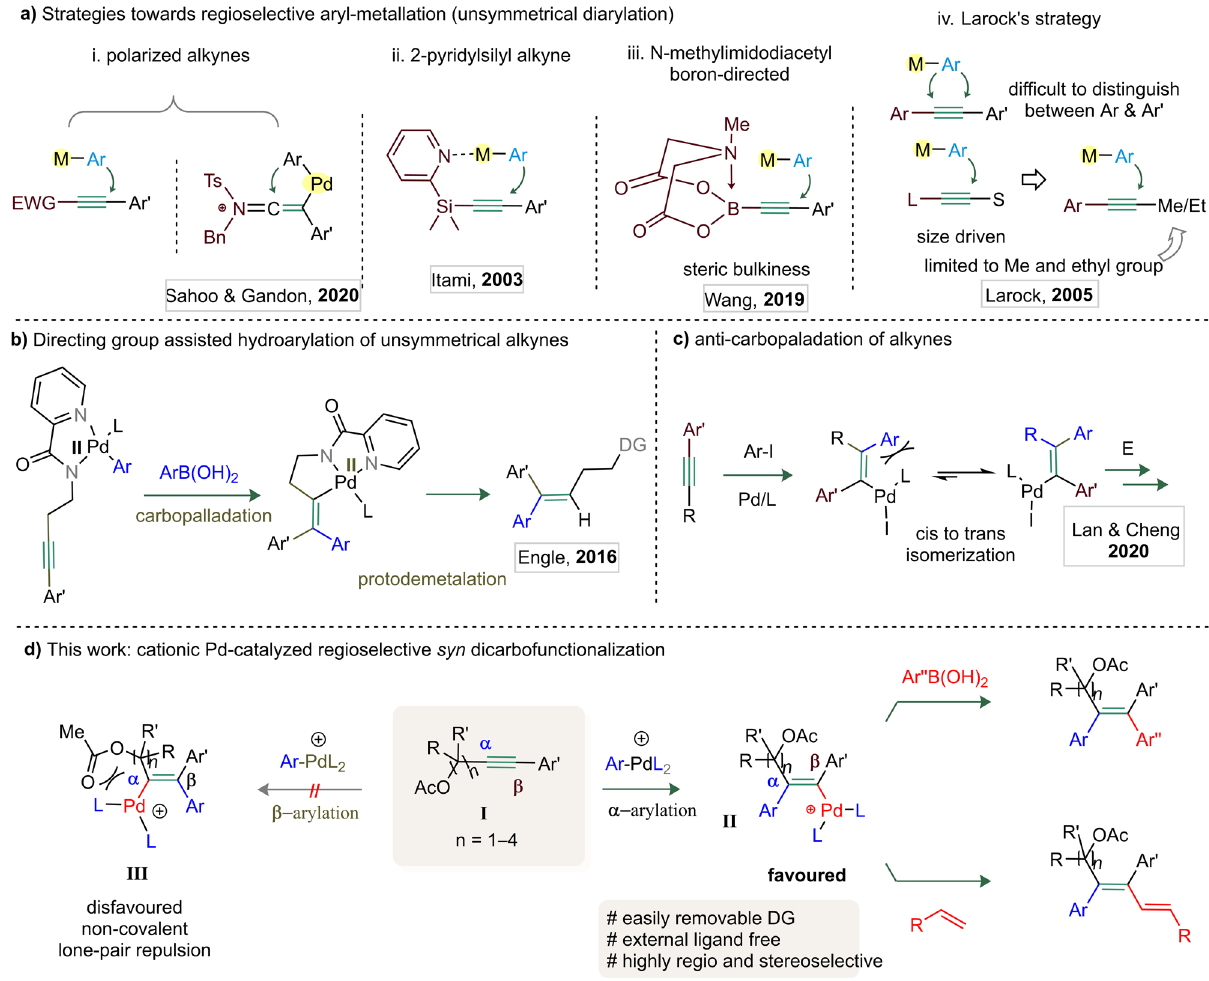
Fig. 1 Comparison between hydro- and difunctionalization of alkynes and the conceptual blueprint of a general cationic Pd-catalyzed dicarbofunctionalization of Yne-acetates. a (i) Difunctionalization of electronically polarized alkynes: the incoming aryl group forms bond at the electron- de fi cient carbon center. (ii) Difunctionalization of 2-pyridylsilyl alkynes: the metal coordination to the pyridyl-N makes the C-aryl bond β to silyl group. (iii) Difunctionalization of N-methylimidodiacyl boron alkynes: the aryl group approaches the less-hindered side of borylated-alkyne. (iv) syn -1,2-Diarylation of diaryl-substituted alkynes occurs at an elevated temperature, providing a mixture of regioisomers. In case of aryl-alkyl alkynes, only the smaller alkyl